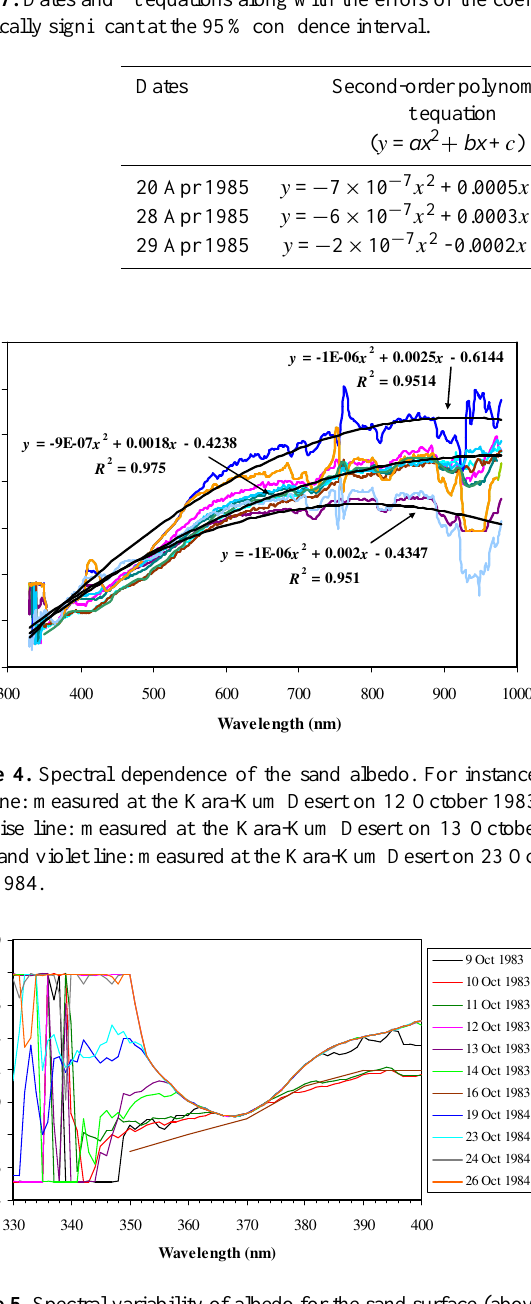
Figure 5. Spectral variability of albedo for the sand surface (above the Kara-Kum Desert) in the UV region measured on 9 October 1983 (black line, 330–400nm), 10 October 1983 (red line, 330— 400nm), 11 October 1983 (green line, 330–400nm), 12 October 1983 (pink line, 330-400nm), 13 October 1983 (violet line, 330– 400nm), 14 October 1983 (bright green line, 330–400nm), 16 Oc- tober 1983 (brown line, 350–400nm with a step of 10nm), 19 Octo- ber 1984 (blue line, 330–400nm), 23 October 1984 (turquoise line, 330–400nm), 24 October 1984 (grey line, 330–400nm), and 26 Oc- tober 1984 (orange line,